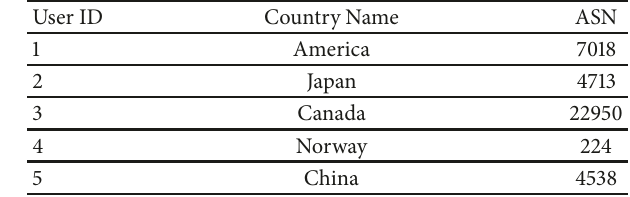
Table 4: Processed location information of